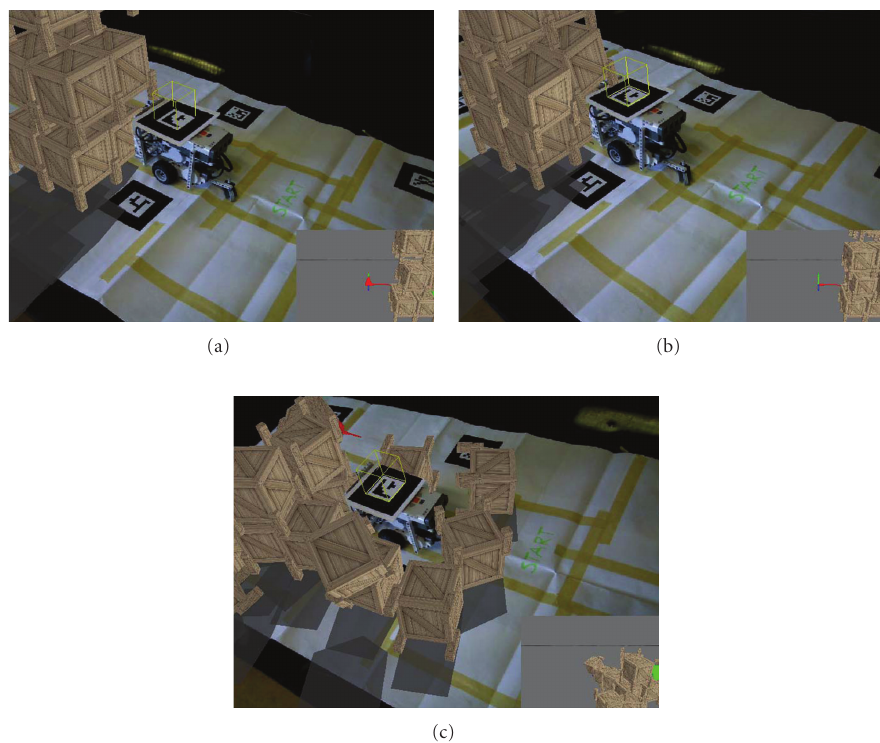
Figure 7: A series of snapshots of the real robotic forklift appearing to physically interact with a wall of virtual